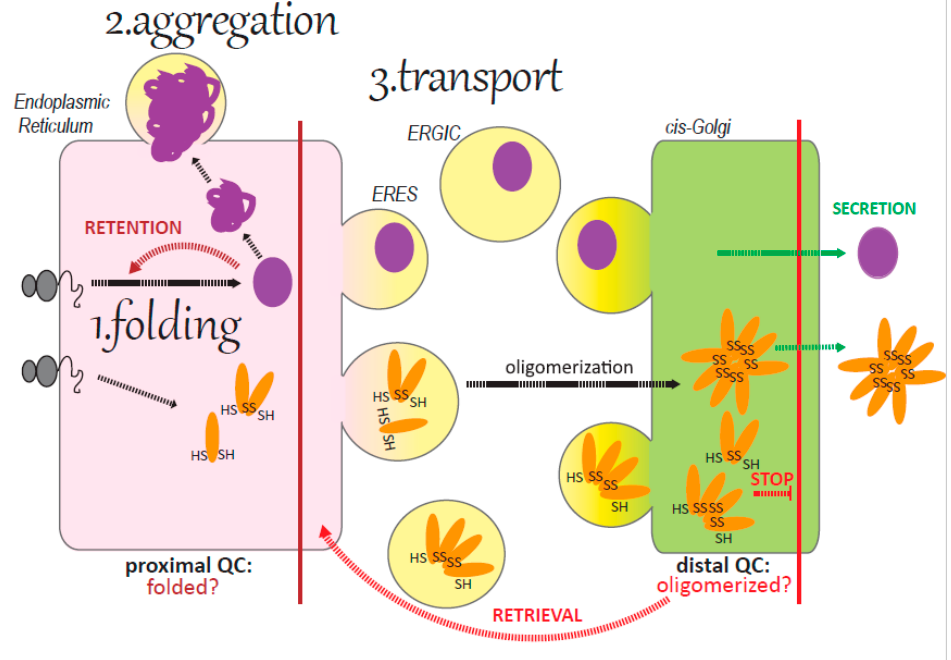
Figure 1. Protein folding, quality control (QC) and transport in the early secretory pathway. Only correctly folded proteins can pass the first step of QC located in the endoplasmic reticulum (ER) (proximal QC) and have access to transport vesicles at the ER exit sites (ERES). Unfolded proteins are instead retained and could eventually form aggregates. In the cisGolgi, a second step of QC (distal QC) ensures that only correctly assembled proteins can proceed along the secretory pathway, while assembly intermediates are retrieved to the ER for another chance of being incorporated into a polymer.